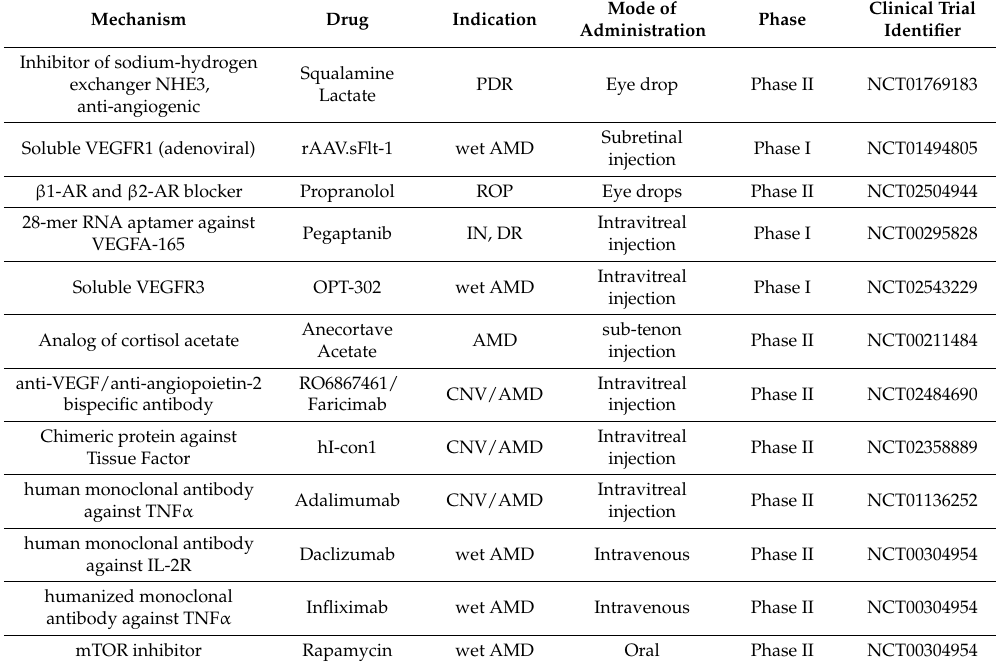
Table 2. Clinical trials for retinal neovascular diseases, Clinicaltrials.gov, November 2018. Mechanism